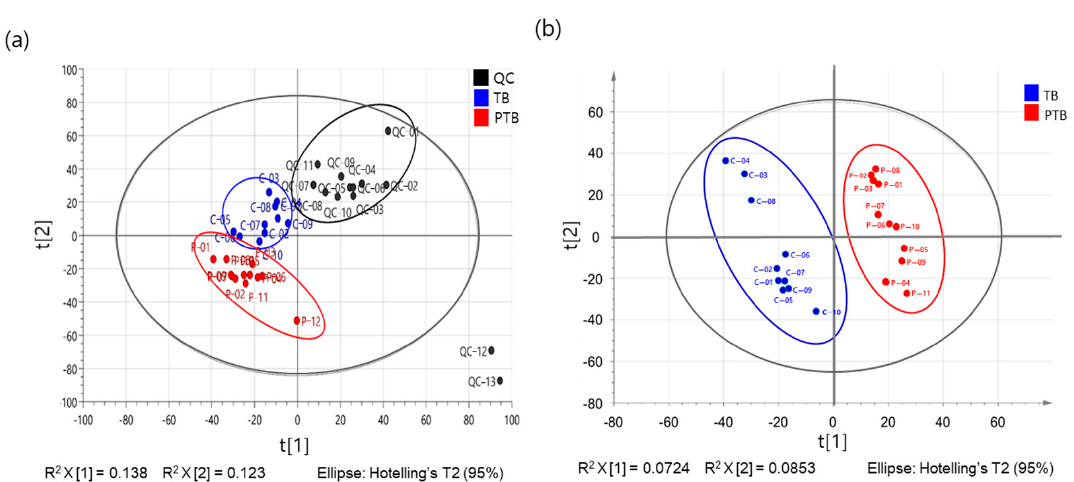
Figure 2. PLS-DA score plots showing that metabolites are differentially categorized in the plasma of PTB compared to TB subjects. ( a ) Quality control (QC) samples ( b ) RPC positive.